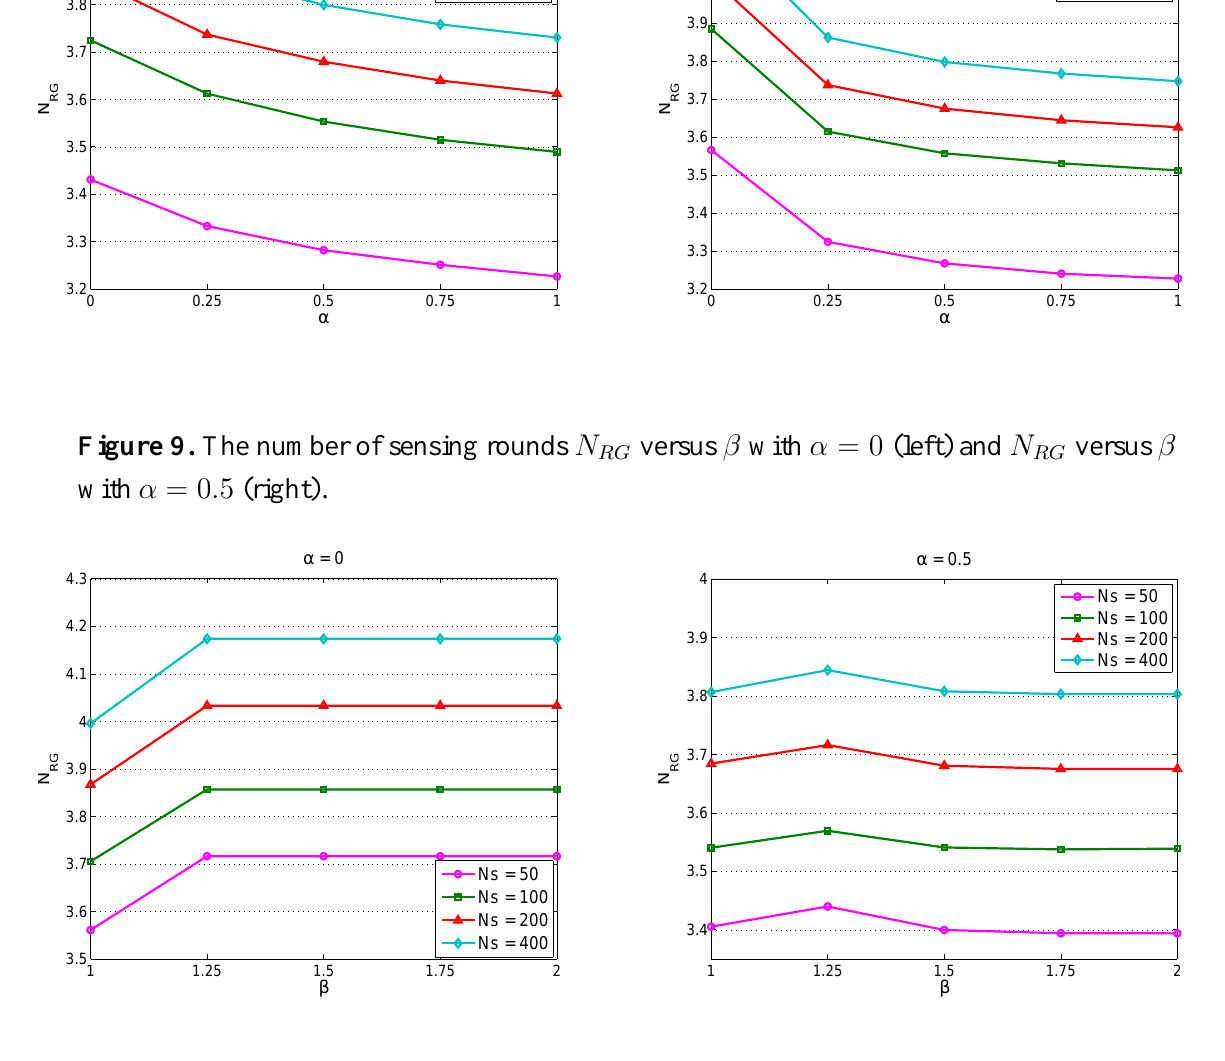
Figure 8. The number of sensing rounds N with β = 1 . 5 (right).